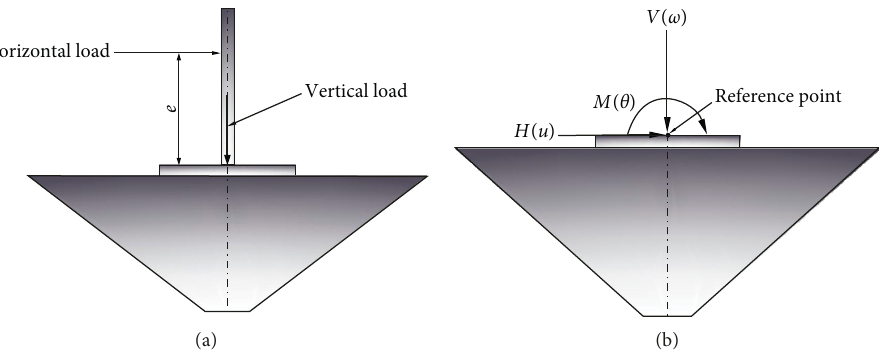
Figure 4: Scale model for cone-shaped foundation. (a) Loading setup of the test. (b) Reference point and notation of displacements.